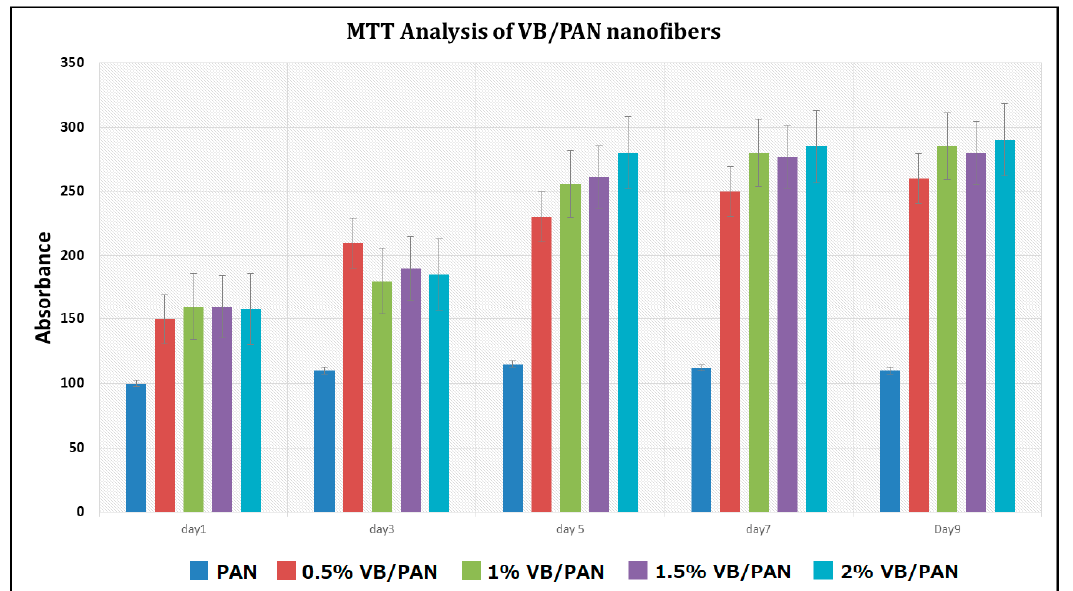
Figure 6. In vitro assessment of PAN and VB/PAN nanofibers.